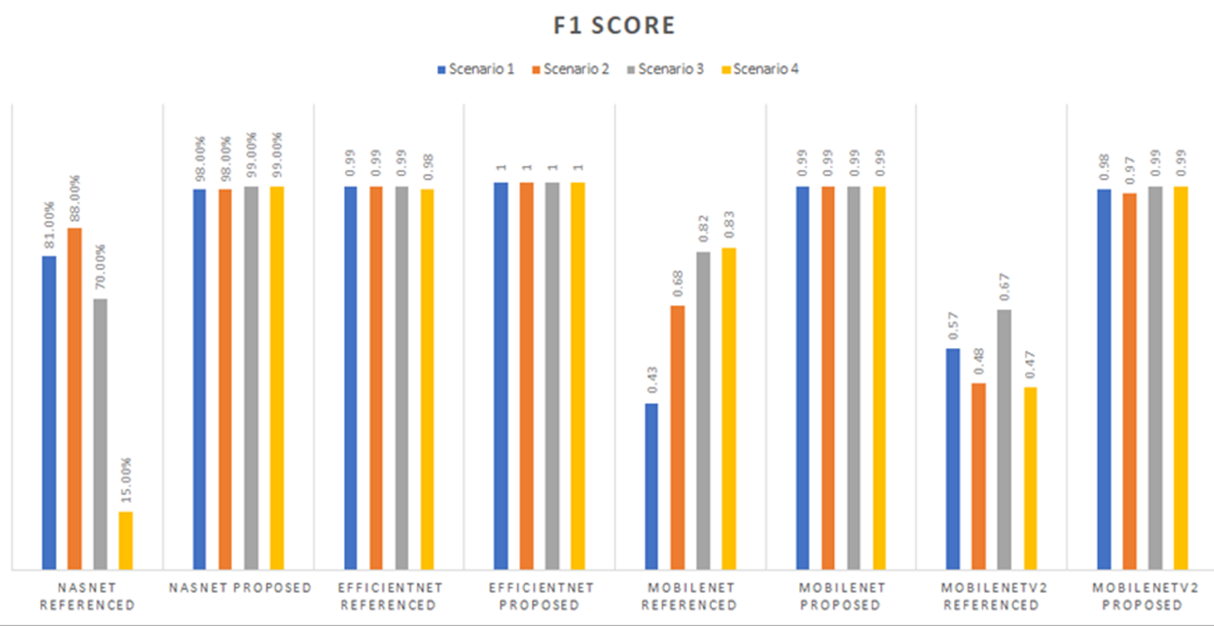
Figure 15. Graphed results of F1-scores for all models developed.